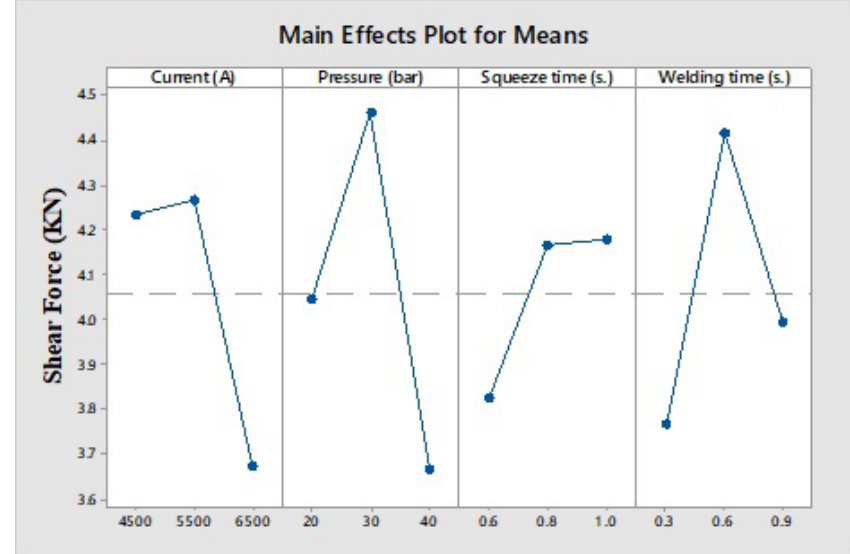
Figure 3. Effect plot of the welding parameters on the tensile-shear force.